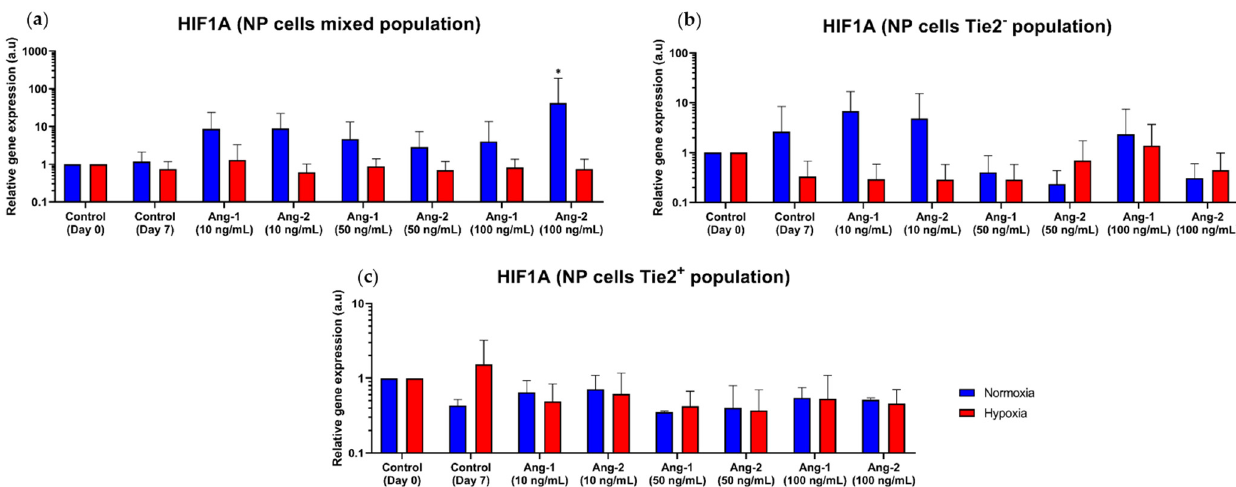
Figure 5. Relative gene expression of the three NP cells populations, comparing the effect of Ang1/2 at different concentrations in normoxia and hypoxia on the HIF1 α gene expression. The control (Day 0) samples were used as reference (set at 1). Ang-1 and Ang-2 were administrated in three concentrations: 10, 50 and 100 ng/mL. ( a ) HIF1 α relative gene expression of NP cells mixed population; ( b ) HIF1 α relative gene expression of NP cells Tie2 − population; ( c ) HIF1 α relative gene expression of NP cells Tie2 + population. Bars represent mean ± SD. A p -value < 0.05 was considered significant. Asterisks within figures denote the degree of statistical relevance observed: * < 0.05.